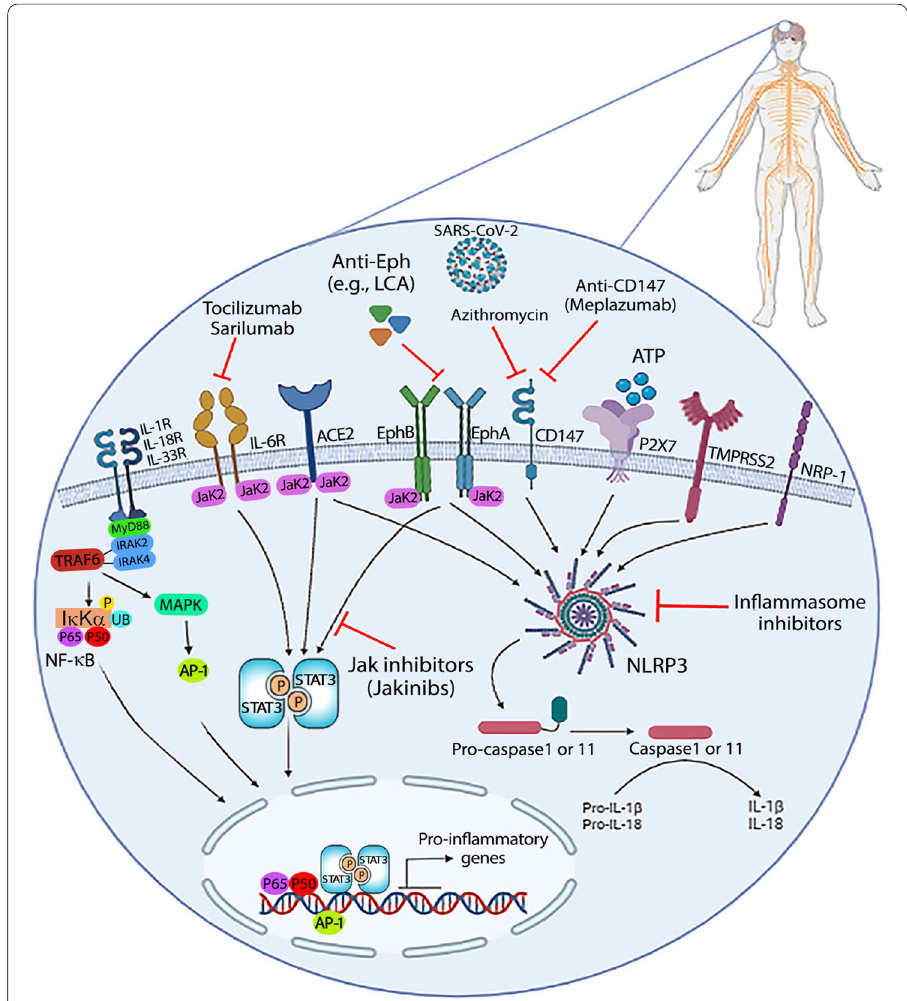
Fig. 1 ACE2, Eph receptors and ephrin ligands, neuropilin-1 (NRP-1), transmembrane serine protease 2 (TMPRSS2), P2X7, and CD147 are shown as entry receptors for SARS-CoV-2 in neurodegenerative diseases. ACE2, EphA/B receptors, and IL-6 receptor use JaK2/STAT3 for signal transduction; thus they may be targeted by JaK inhibitors (JaKinibs). Moreover, ACE2, EphA/B receptors, TMPRSS2, (NRP-1), P2X7, and CD147 can activate NLRP3 inflammasome to secrete IL-1β and IL-18; therefore, they may be targeted by inflammasome inhibitors or IL-1β and IL-18 monoclonal antibodies or